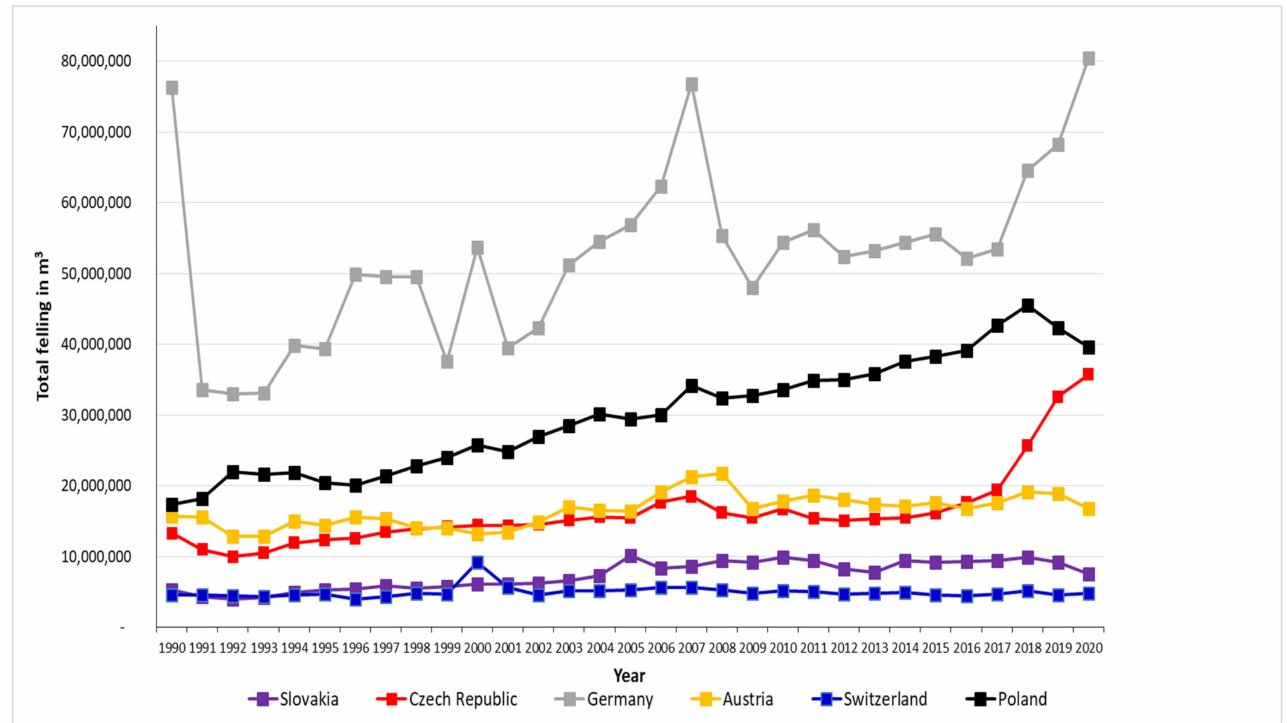
Figure 3. Time series development of total timber harvesting (m 3 ) in central Europe selected countries.